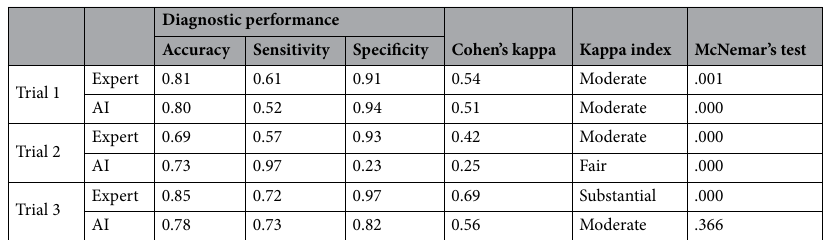
Table 5. Diagnostic performance and level of agreement in each Trial. AI, artificial intelligence.